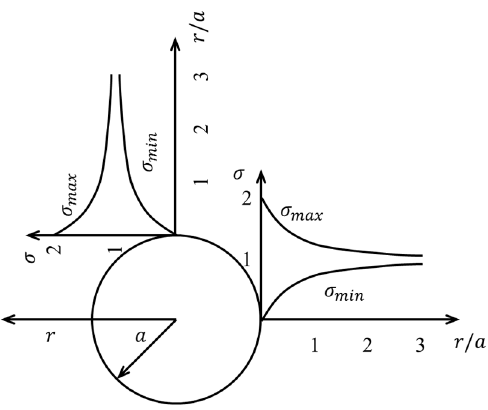
Figure 4. Schematic of the stress variable concept where “a” is the tunnel radius.